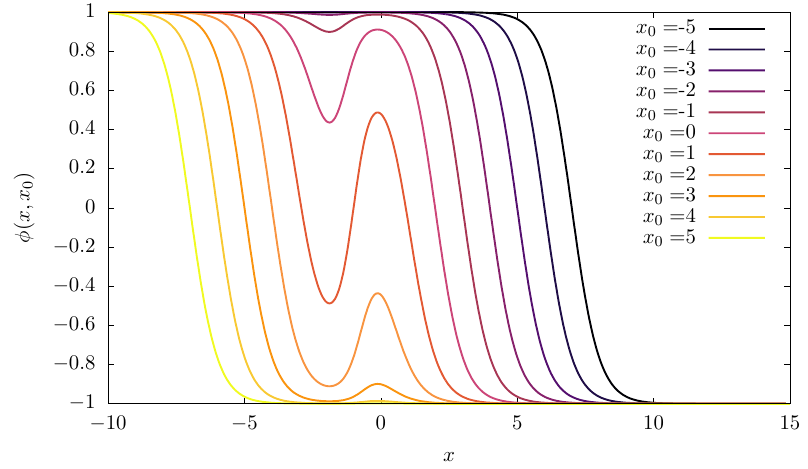
Figure 1 . Pro(cid:12)le of the BPS antikink for the (cid:30) 4 BPS-impurity model (2.9) with (cid:11) = di(cid:11)erent values of the moduli space parameter x 0